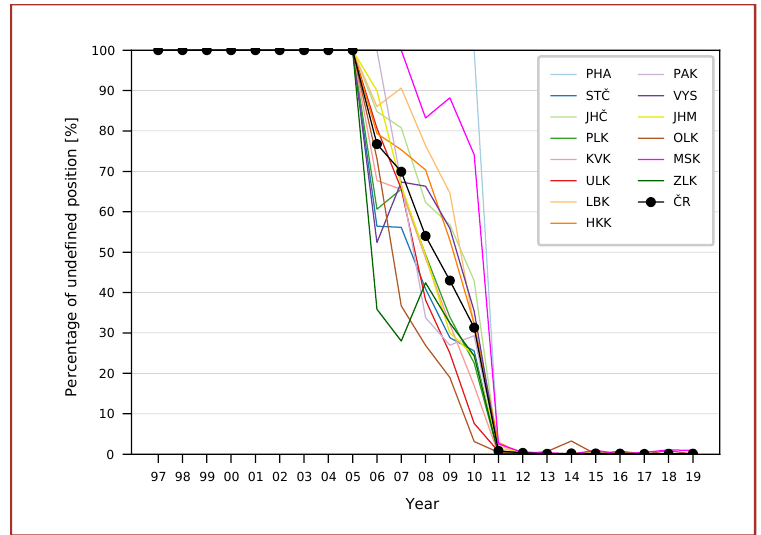
Figure 2. Regional wildland fire coordinate logging. The graph depicts the percentage of undefined coordinate values from all wildland fires in a given year for 14 regions of the Czech Republic, including the Capital City of Prague and for the whole of the Czech